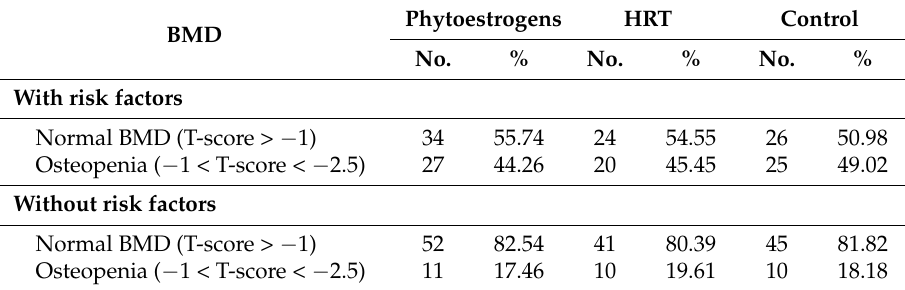
Table 3. Distribution of cases by T-score depending on the presence of risk